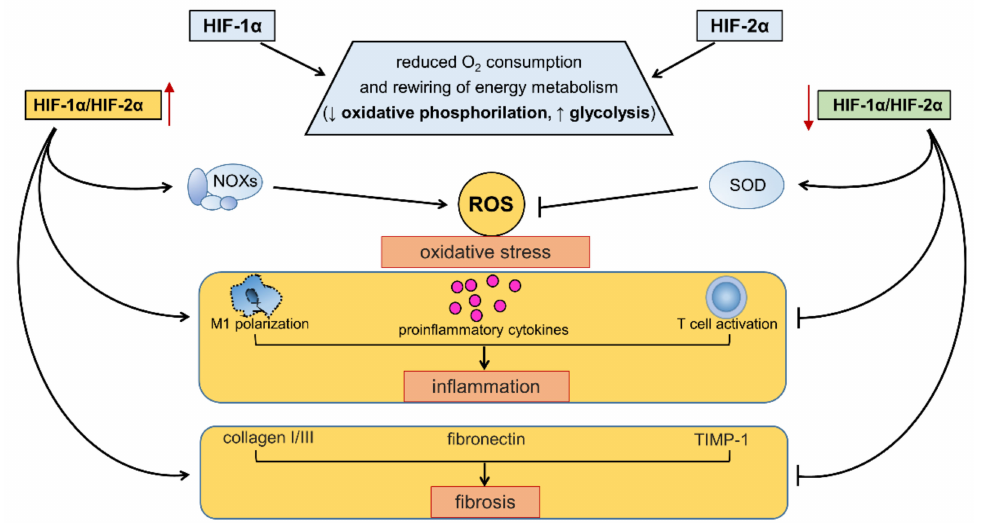
Figure 5. Effects of hypoxia-inducible factor (HIF)-1 α , HIF-2 α , and changes in HIF-1 α /HIF-2 α balance on energy metabolism, redox balance, inflammation, and fibrosis. Refer to the main text for detailed description and references. NOXs = NADPH oxidases; ROS = reactive oxygen species; SOD = superoxide dismutase; M1 = classically activated